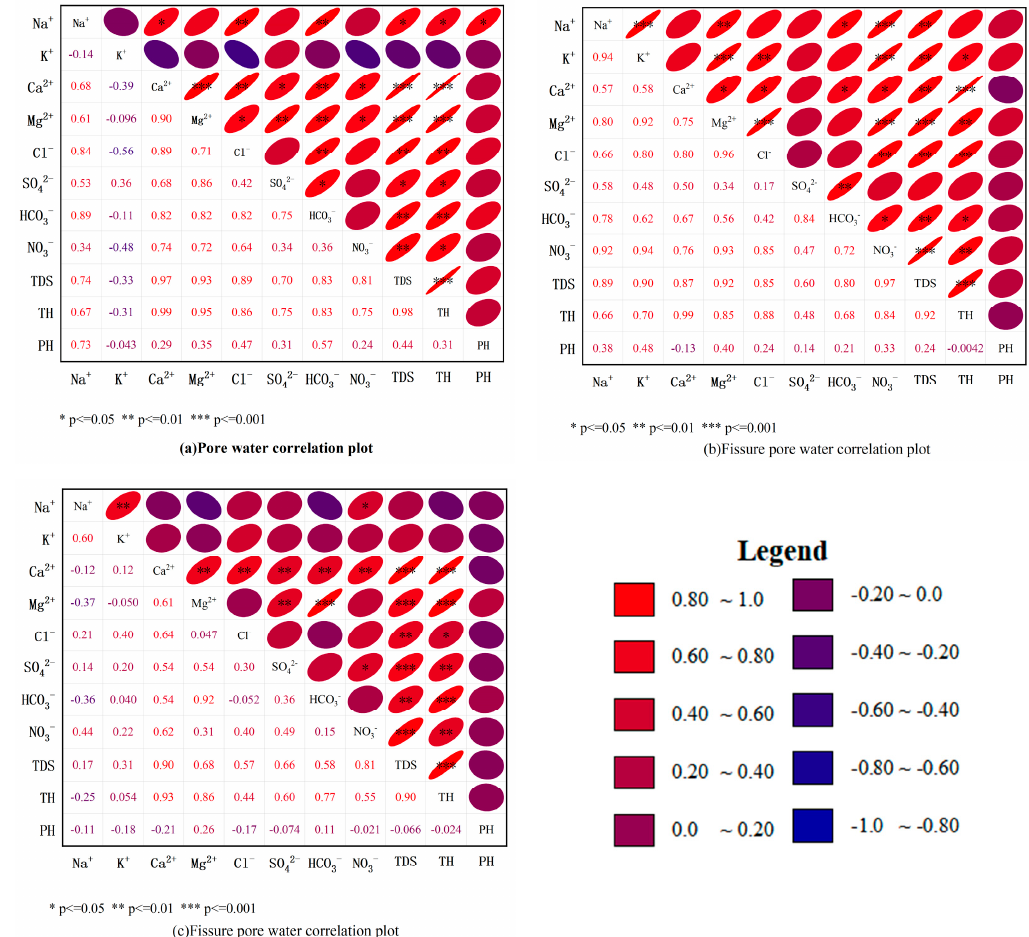
Figure 6. Correlation plots between ionic components of three groundwater types.